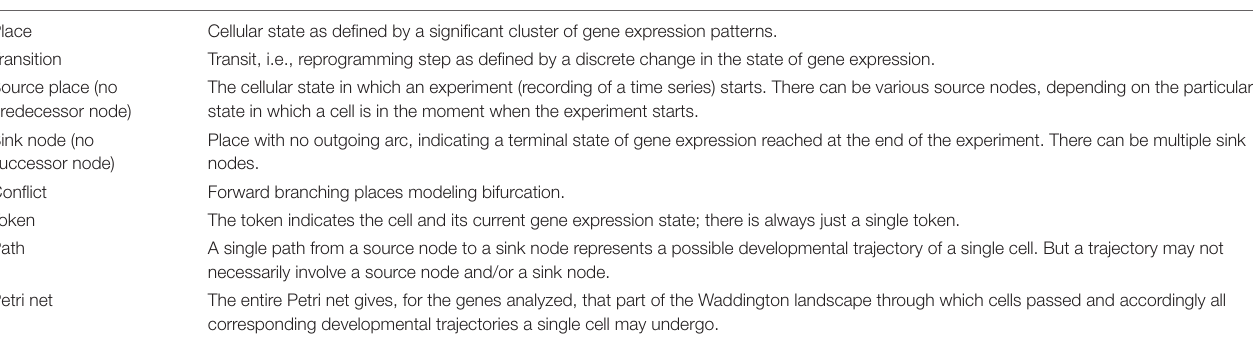
TABLE 3 | Terminology, basic modeling principles, and Petri net